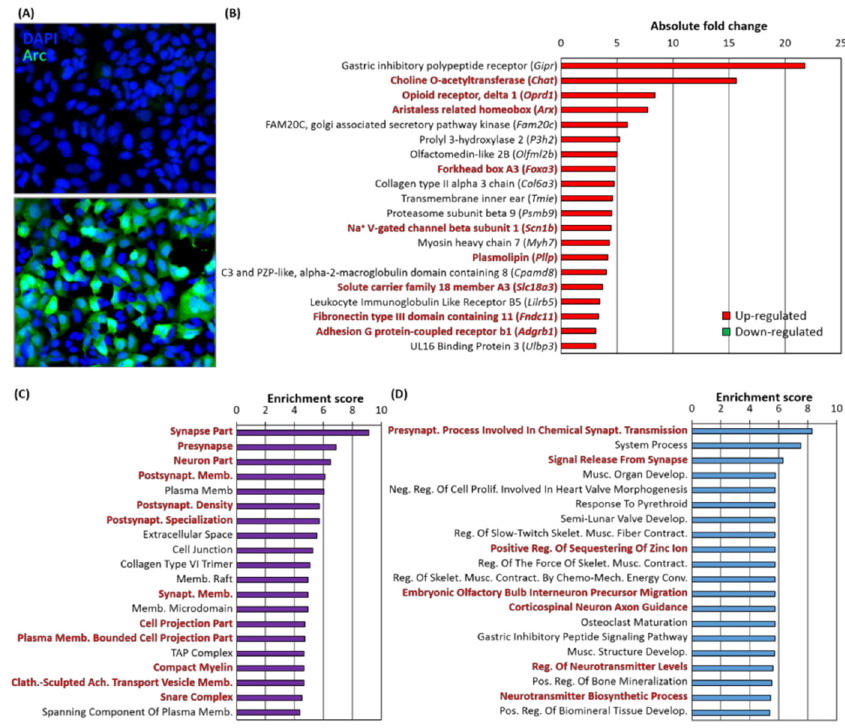
Figure 19. HEK293T cells exhibit neuronal properties upon induced expression of Arc. ( A ) Endogenous Arc expression was enhanced in HEK293T cells by targeting two single guide RNAs (sgRNAs) containing MS2 aptamers to the Arc promoter with the CRISPR/Cas9 Synergistic Activation Mediator system (see Methods for details). As a negative control, we used two sgRNAs targeting the promoter of the lac operon. Control cells ( top ) and Arc-induced cells ( bottom ) were stained for Arc (green) and DNA was labelled with DAPI (blue). About 90% of the cells expressed Arc. Scale bar is 30 µm. ( B ) Graph showing the top 20 differentially expressed genes upon the induction of endogenous Arc in HEK293T cells. RNA-Seq was used to compare the mRNA levels between the Arc-induced and control HEK293T cells. Neuronal genes are bolded and highlighted in red. ( C , D ) GO analysis of the differential expressed genes upon overexpression of Arc. The top 20 cellular components ( C ) and biological processes ( D ) are presented. Neuronal features were bolded and highlighted in red. Na + : sodium; V-gated: voltage-gated; Postsynapt: postsynaptic; Memb: membrane; Synapt: synaptic; Clath: clathrin; Ach: acetylcholine; Presynapt: presynaptic; Musc: muscle; Develop: development; Neg: negative; Reg: regulation; Prolif: proliferation; Skelet: skeletal; Contract: contraction and Mech: mechanical; Conv: conversion. Together with the results obtained with Arc knockdown in neurons, this finding strongly implicates Arc as a transcriptional regulator of neuronal development, synaptic function, plasticity and intrinsic excitability. 4. Discussion Activity-regulated cytoskeleton-associated protein (Arc) was discovered in 1995 as a neuronal activity-dependent immediate early gene [1,2], which is rapidly transcribed in